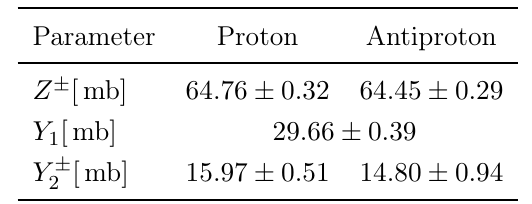
Figure 5 . Measured total proton-deuterium and antiproton-deuterium cross-sections as function of proton momentum are shown with green squares and red dots, respectively. Fits according to the model described in the text are overlaid. Data are taken from ref. [26].